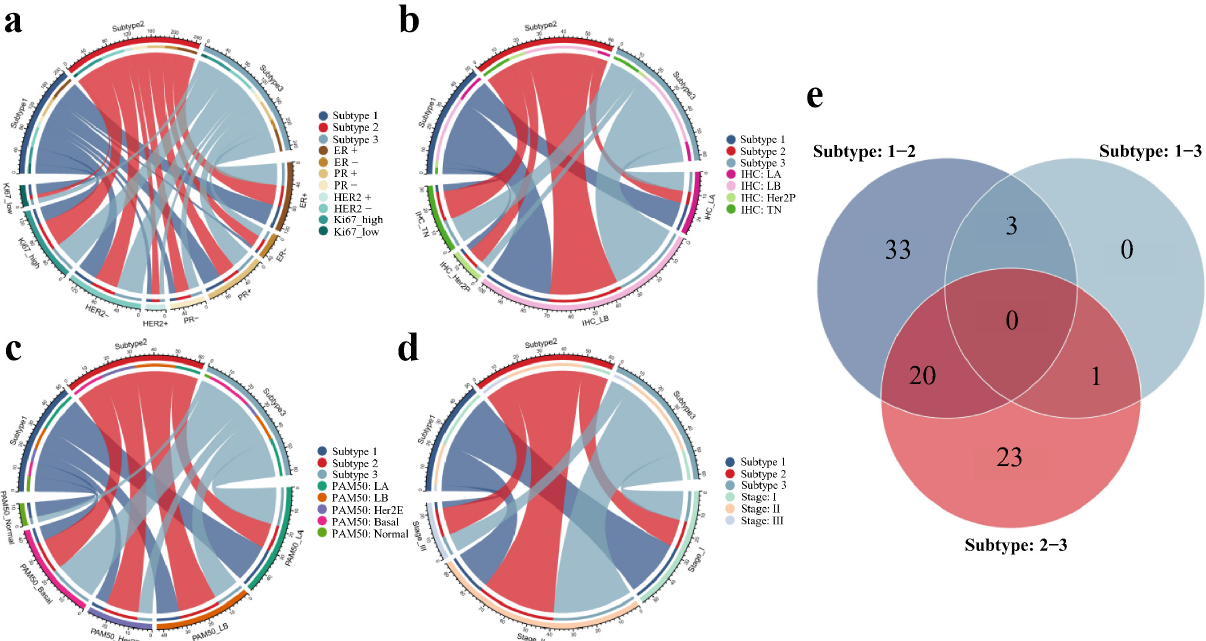
Figure 5. Associations of the DCE-MRI subtypes with clinical and pathway characteristics. The chord diagrams between three imaging subtypes and clinical IHC receptors ( a ), IHC-based subtypes ( b ), PAM50 molecular subtypes ( c ), and clinical stages ( d ) in the discovery cohort were described. Venn diagram of the differentially enriched KEGG pathways between two of three imaging subtypes ( e ).